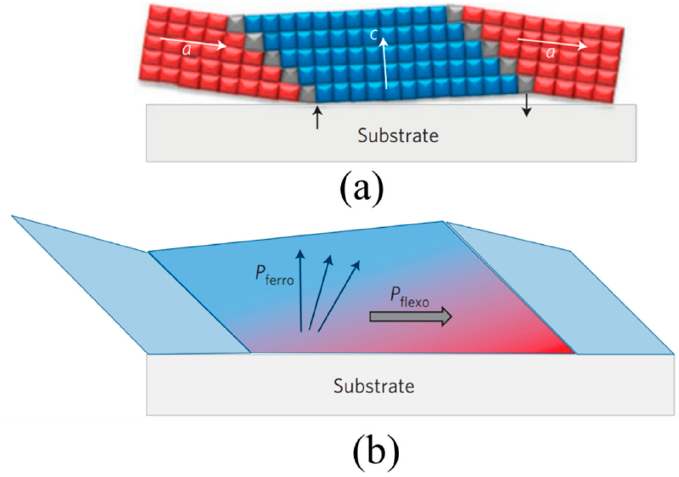
Figure 16. ( a ) Schematic representation of the domain structure in a film with a–c domains. The black arrows represent the stresses that must be applied to the twinned film to flatten it onto the substrate. ( b ) The flexoelectric polarization (grey) induces a rotation of the ferroelectric polarization of the c domain (blue). Reprinted with permission from [97]. Copyright 2011 Springer Nature.